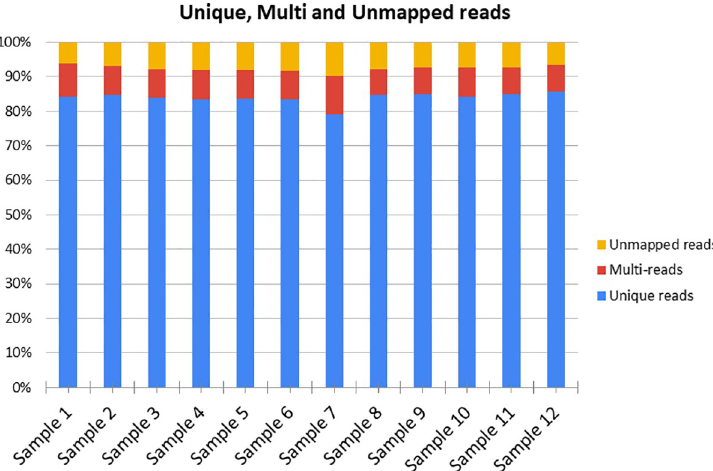
Fig 1. Mapping statistics. For each sample are reported the percentages of the uniquely mapped reads, multi-reads and unmapped reads against the Sus scrofa reference genome 11.1.